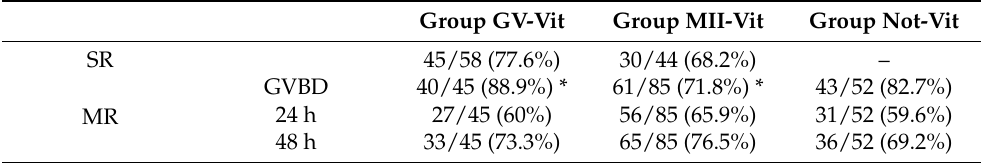
Table 1. Rates calculated according to the groups of study. Survival rate (SR), maturation rates (MR): MR by germinal vesicle breakdown (GVBD); after 24 h and 48 h. Average percentage by group and p -value. (*) p -value < 0.05 Group GV-Vit vs. Group MII-Vit. (–) data not possible. Group GV-Vit Group MII-Vit Group Not-Vit SR 45/58 (77.6%) 30/44 (68.2%) – GVBD 40/45 (88.9%) MR